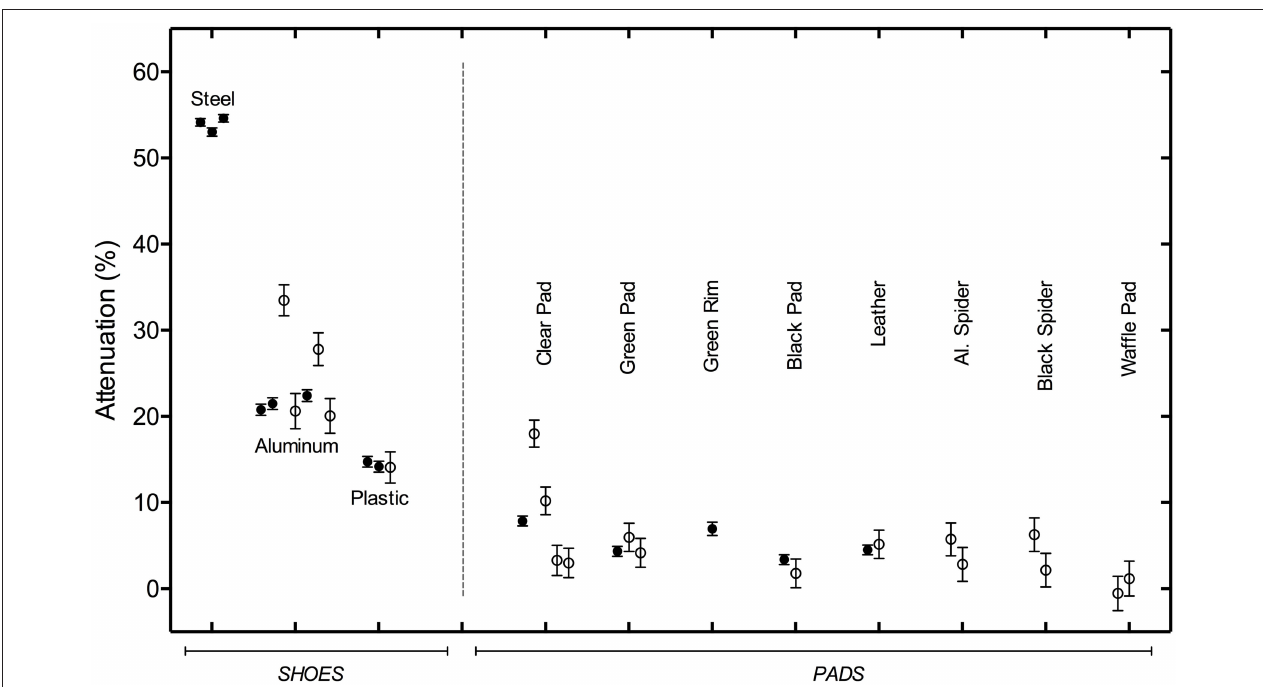
FIGURE 1 | Shoe and Pad Attenuation (with uncertainties). Attenuation for each shoe or pad imaged is shown as a circle for the mean attenuation, with error bars for the 95% confidence level. Filled circles indicate that the entire shoe or pad was traced, and open circles indicate ROI where a localized spot trace was used. Error bars on the spot traces are generally larger because of the smaller area included in the ROI. Two shoes were imaged twice, in different data sets. The difference shown for the two measurements of the attenuation of the small aluminum shoe and the plastic shoe shows how reproducibly the shoe outline could be traced.